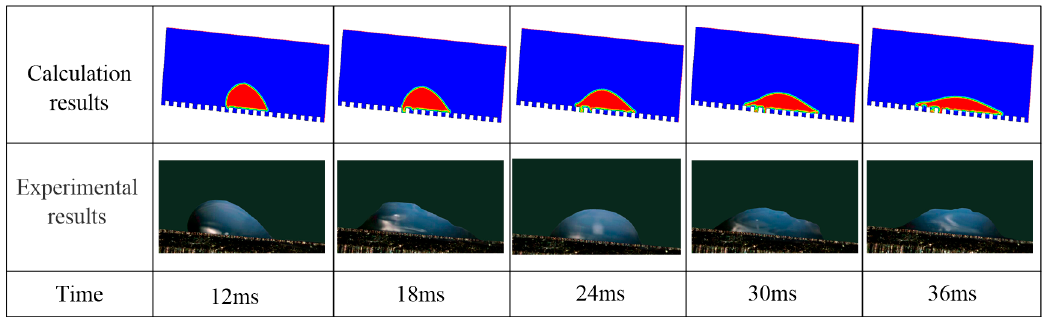
Figure 7. Experimental and CFD calculation results of vibrating drop motion in a single period.